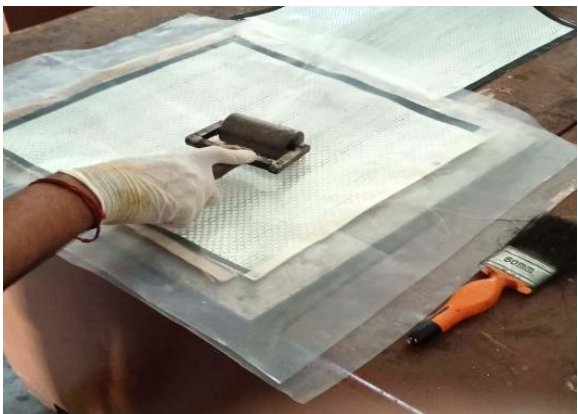
Fig. 1. Fabrication of glass/jute hybrid laminates using hand layup